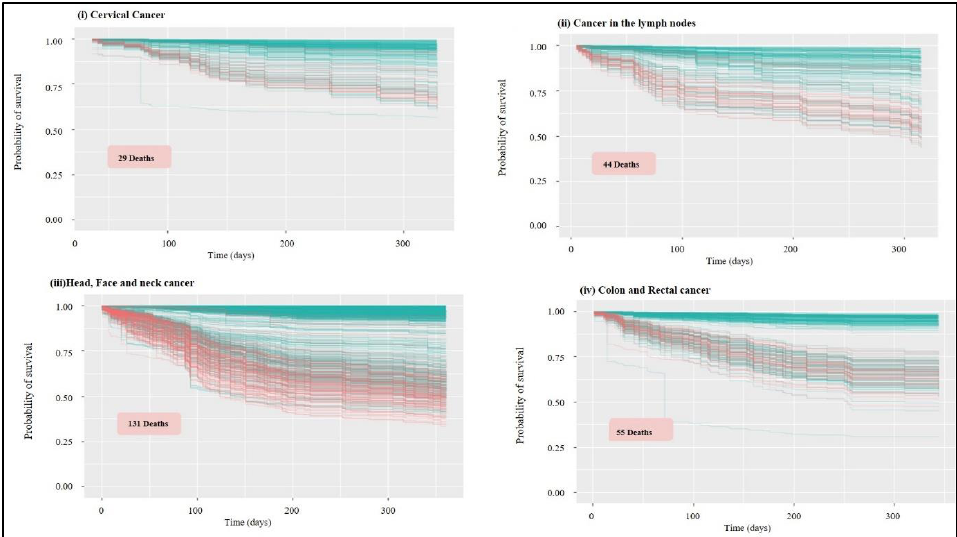
Figure 7. Survival graphs: probability of survival over time for the untrained group of patients (out-of-bag group), representing from top to bottom: ( i ) cervical cancer; ( ii ) cancer of the lymph nodes; ( iii ) cancer of the head, face and neck; ( iv ) colon and rectal cancer. In red is the prediction of death occurrences, and in blue is survival.